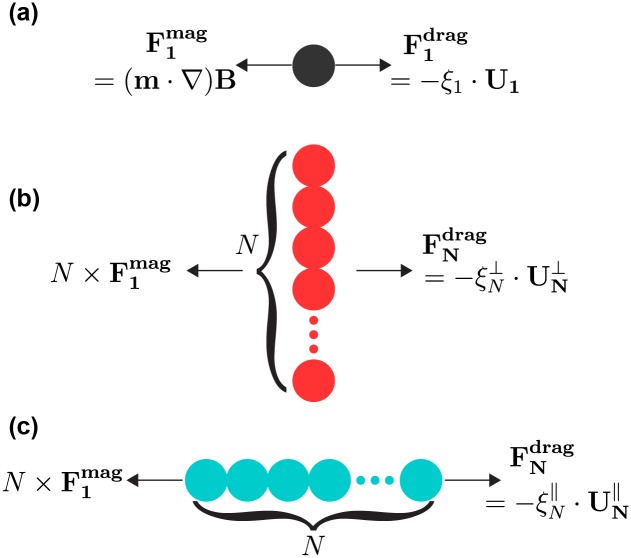
Principle of drag coefficient calculations.Schematic illustration of magnetic force and drag force acting on (a) single bead, (b) bead-chain moving perpendicular to its axial axis, and (c) bead-chain moving parallel to its axial axis. For a given bead-chain of length N, the drag coefficient is calculated using Eqs 9 and 11.